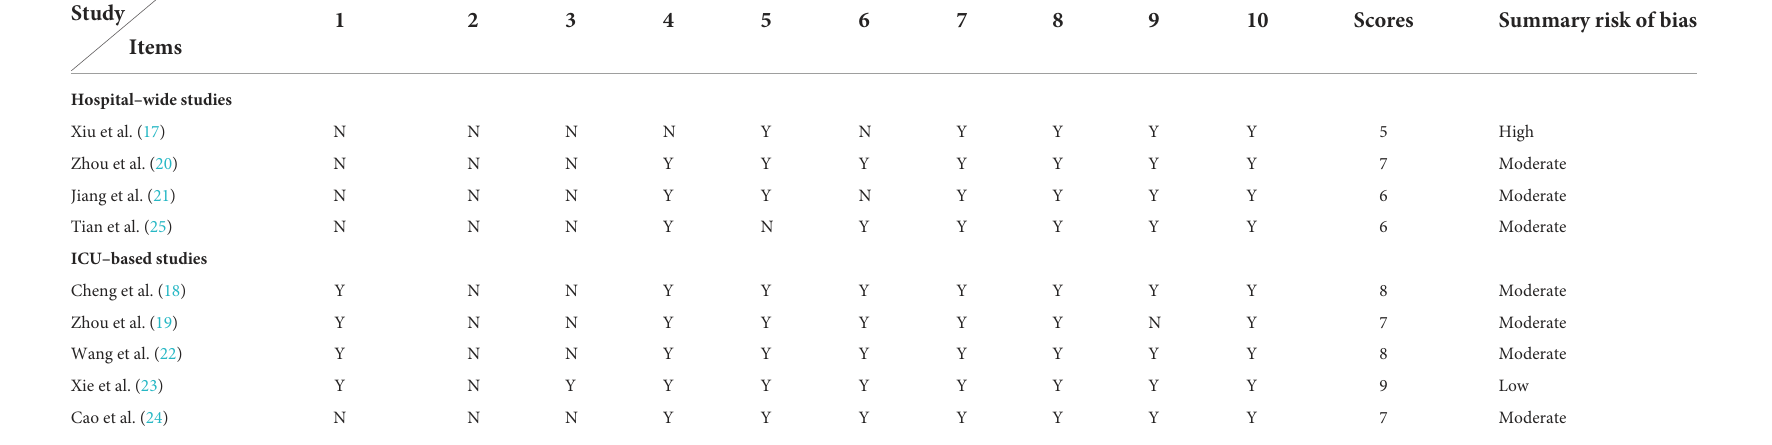
TABLE 4 Risk of bias for included